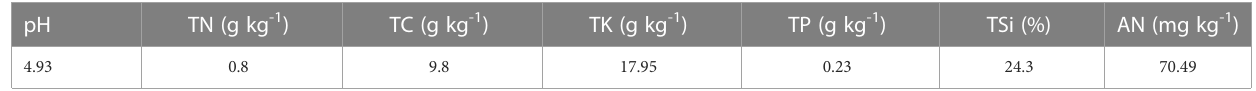
TABLE 1 Basic chemical properties of the pot